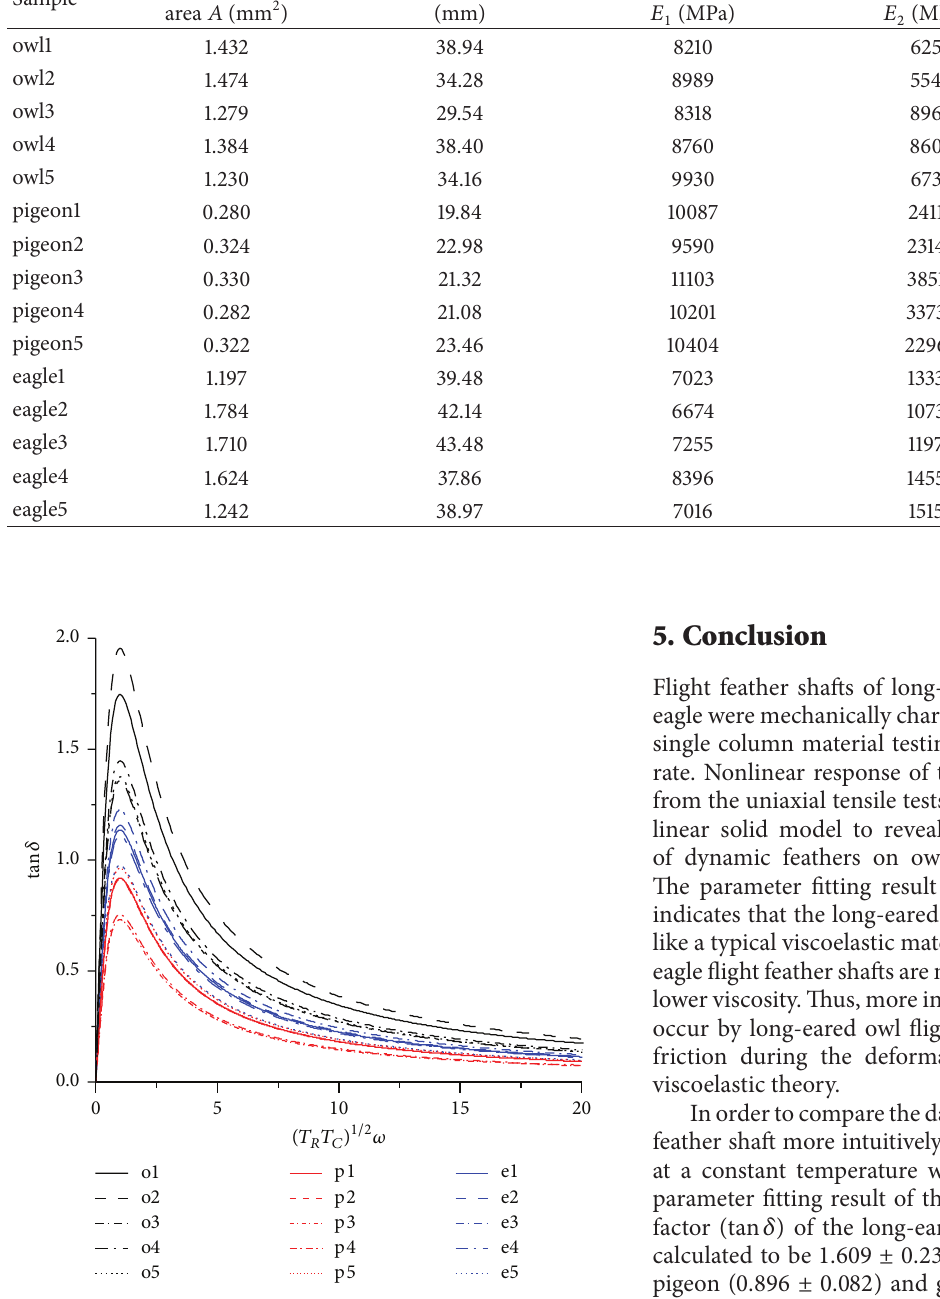
be an important factor to reduce or eliminate the mechanical vibration and free vibration of the owl feathers as soon as possible. As a result, noise caused by wing vibration and feather friction from the relative motion would effectively be suppressed by the long-eared